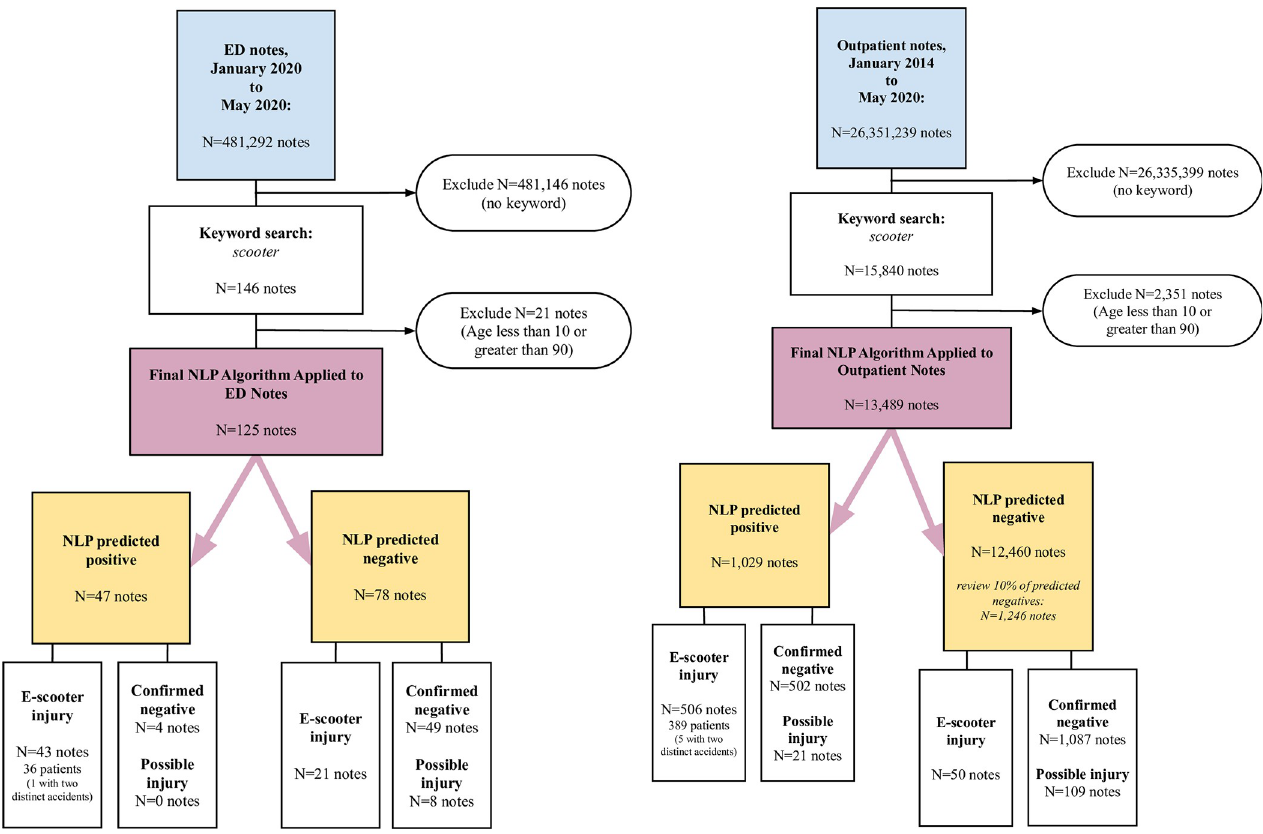
Fig 2. Flowchart of testing process for the predictions of our NLP algorithm � . ED notes in panel A, and outpatient notes in panel B. As in S1 Fig in S1 File , “Confirmed Negative” refers to a note that, on review by investigators, did not suffer an e-scooter injury, while “Predicted Negative” refers to a note that our NLP algorithm did not predict as an e-scooter injury. Any cases of possible but not necessarily probable e-scooter injury are not included in our injury tallies, and are treated as non-injuries (negatives) in metrics of diagnostic performance in S2 Table in S1 File (as a secondary analysis, we computed and present diagnostic performance under the alternate assumption that possible cases were e-scooter injuries in S4 Table in S1 File ). Counts refer to numbers of notes, rather than injuries or